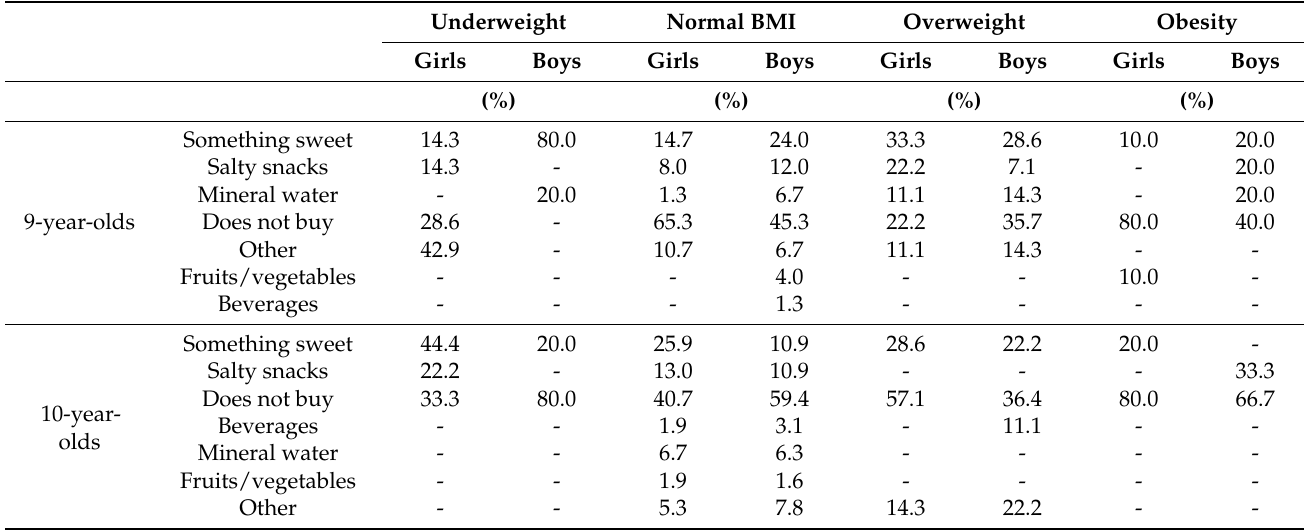
Table 7. Cont. Underweight Normal BMI Overweight